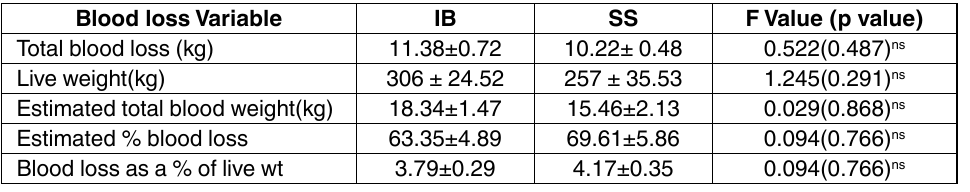
Table 4. The various blood loss variables of imperfectly bled (IB) and scientifically slaughtered (SS) animals